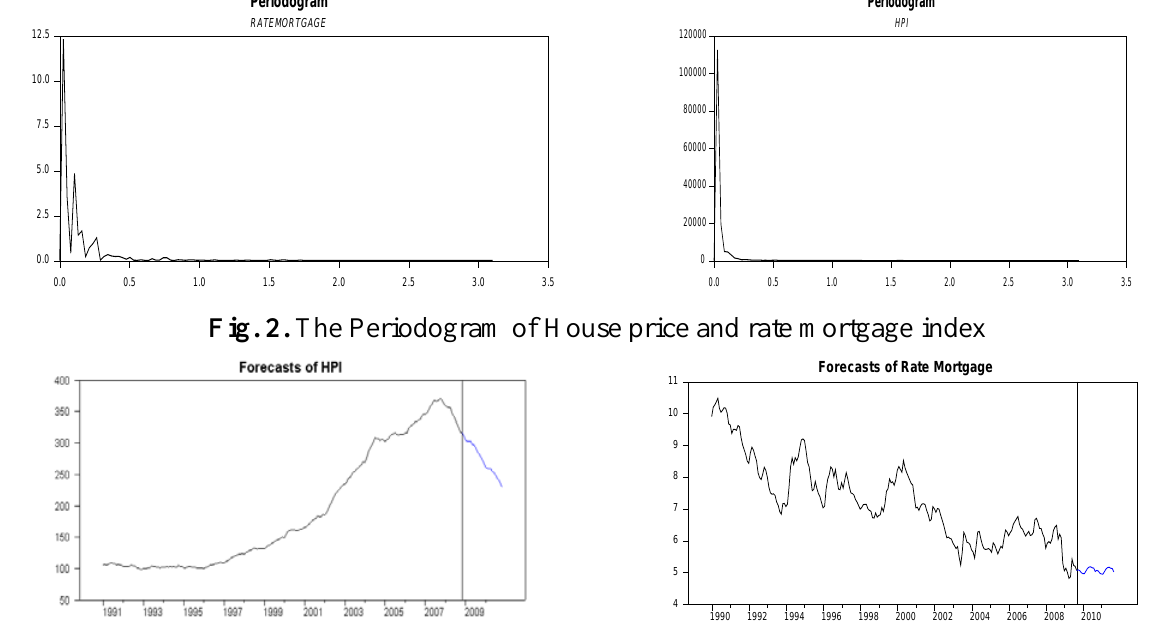
Fig. 3. The forecasting of House price and rate mortgage